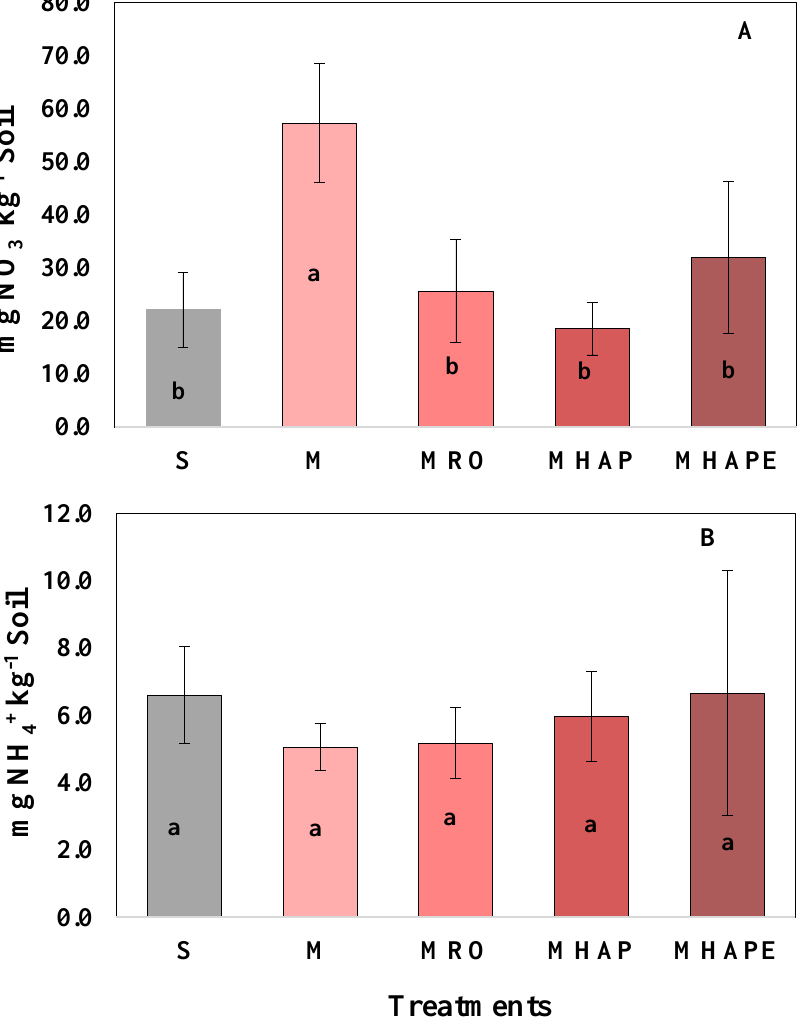
Figure 3. The effect of treatments on corn soil nitrate-N ( A ) and ammonium-N ( B ) concentrations. The mean is calculated for n = 4; the vertical bar represents the standard deviation of the mean. Here, S = soil control; M =manure control; MRO = manure + red oak biochar; MHAP = manure + highly alkaline porous biochar; MHAPE = manure + corn feedstock autothermal porous Fe-engineered biochar. Different letters show the treatments that are statistically different at p < 0.05